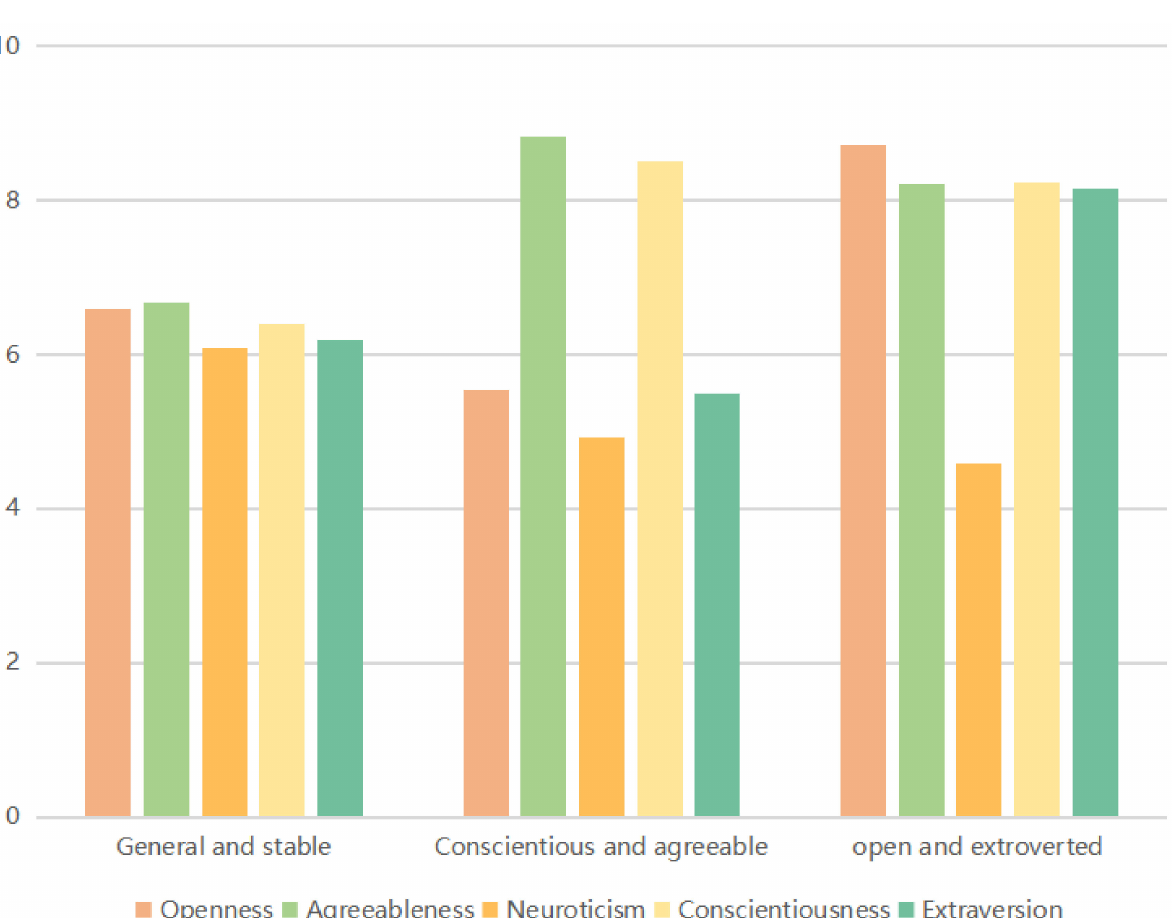
Figure 1. Descriptive statistics for the three-profile